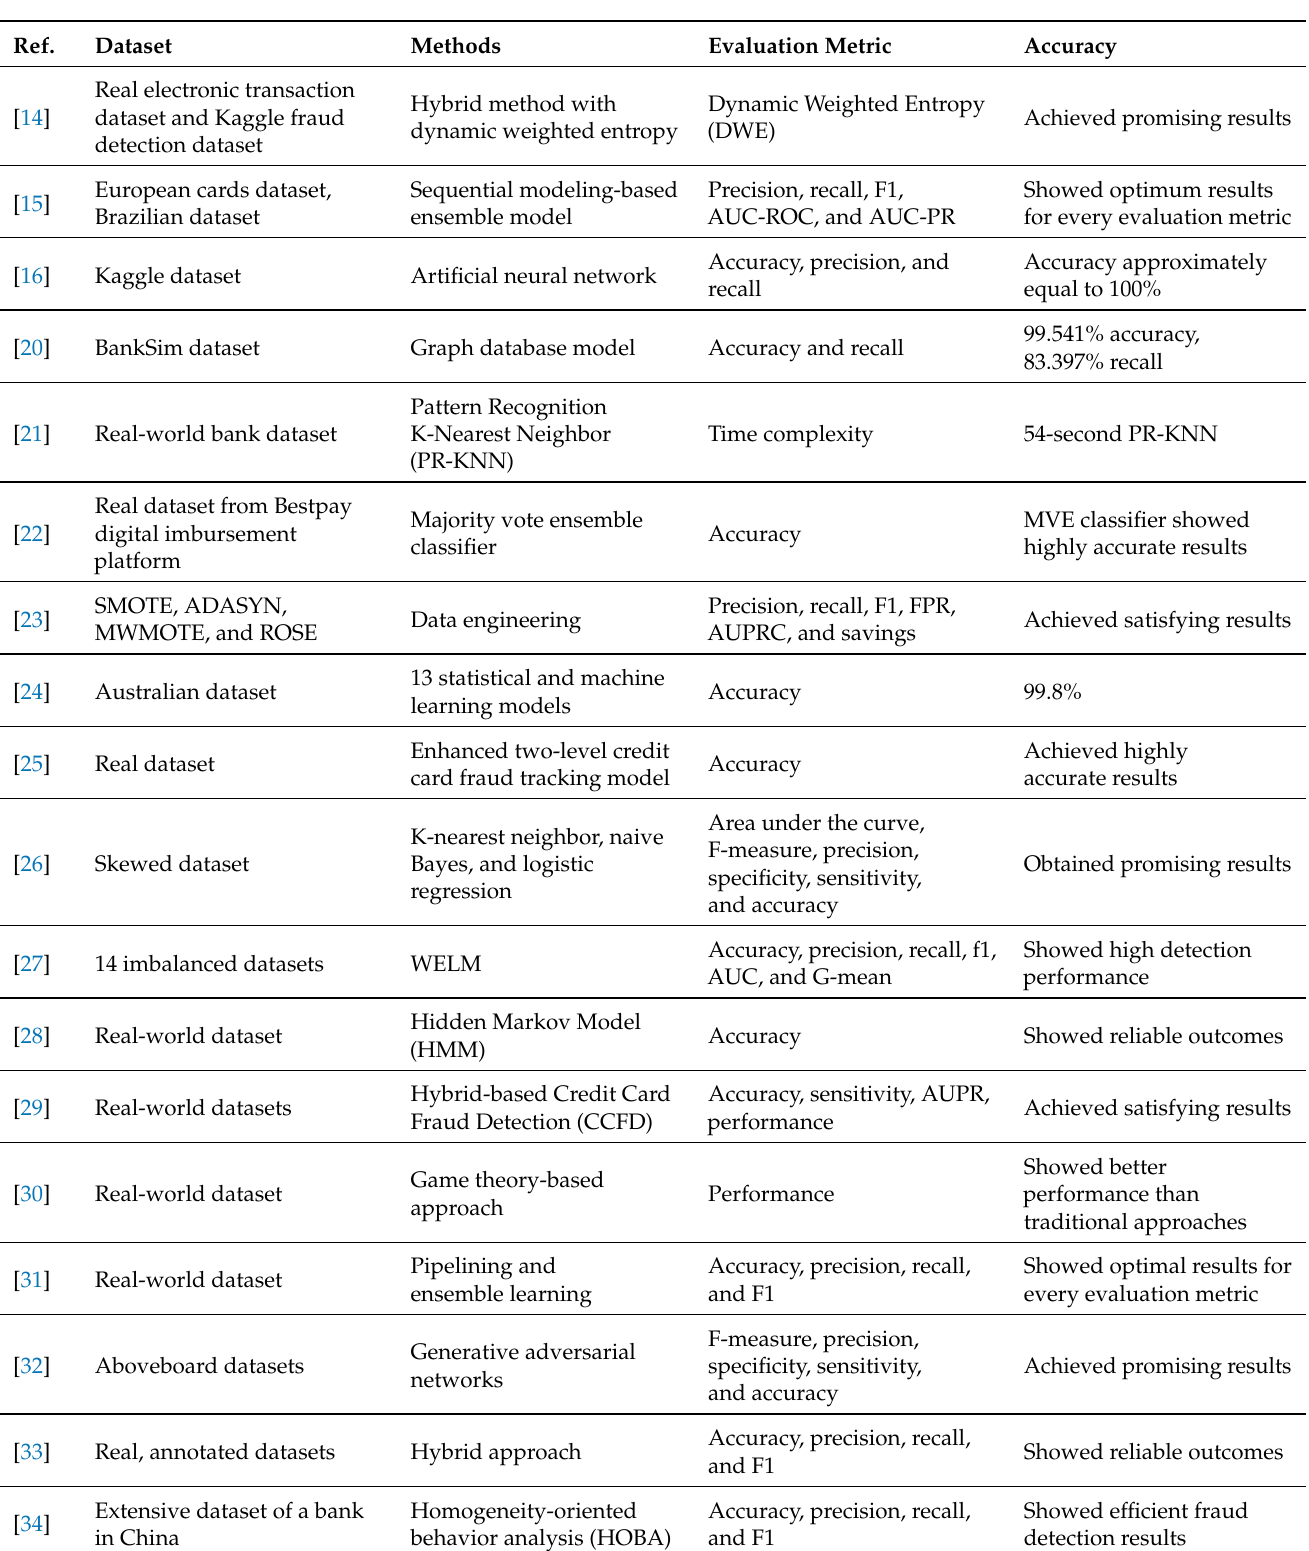
Table 1. Summary of recent studies based on computer vision for credit card fraud detection.